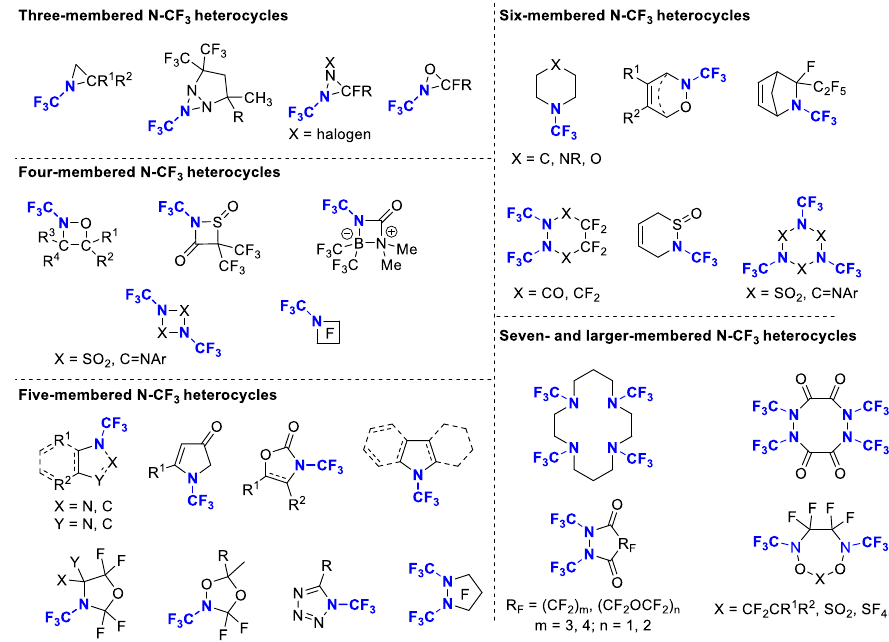
Figure 2. Variably sized N-heterocycles containing the N -trifluoromethyl motif.